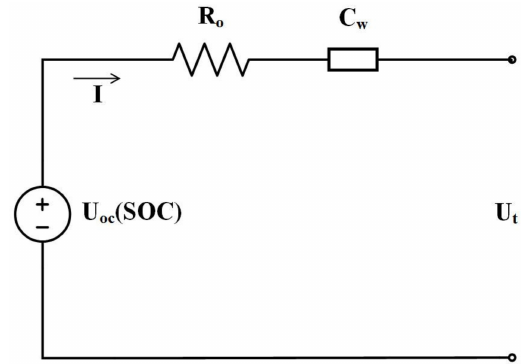
Figure 15. Simplified fractional order model